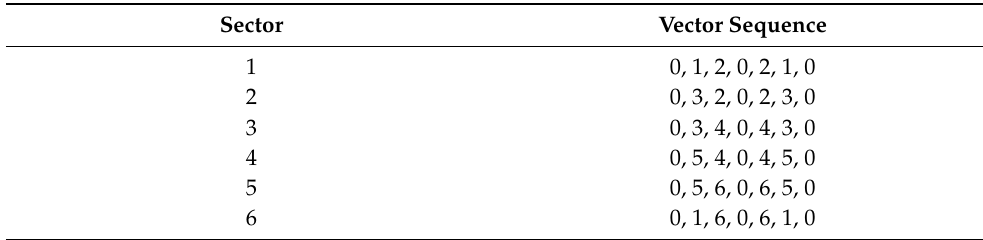
Table A1. Vector switching sequences of the inner hexagon, by the ith designation (V i ).